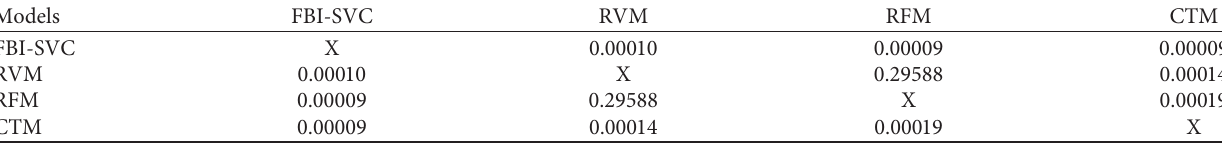
Table 3: p values obtained from Wilcoxon signed-rank test results with F1 score index.